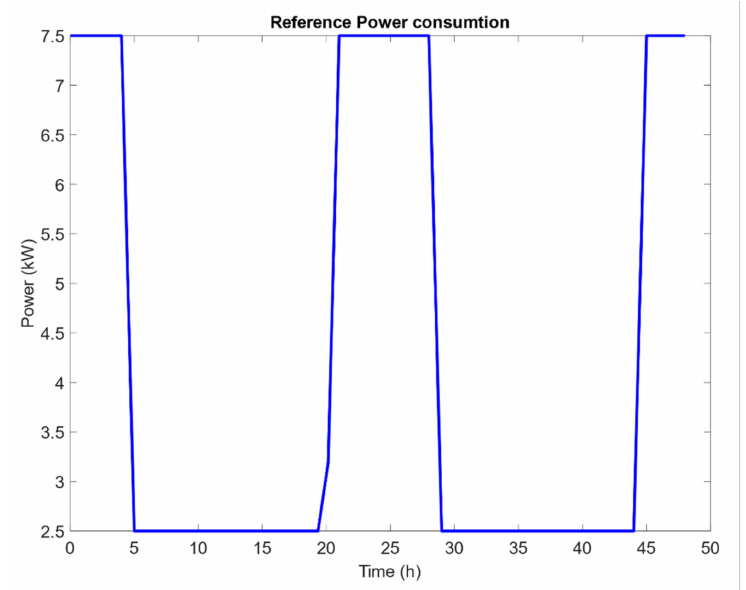
Figure 16. Requested AC Power